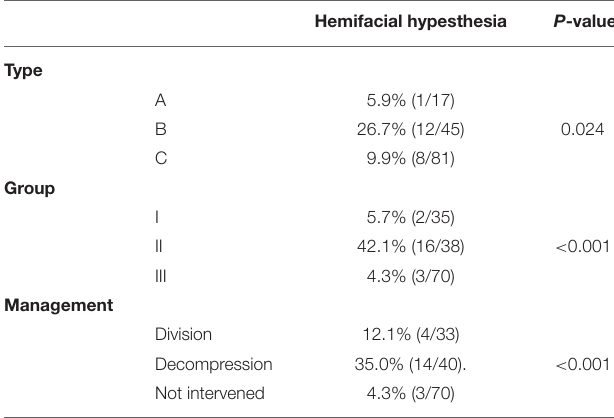
TABLE 2 | The rate of postoperative hemifacial hypesthesia in patients with VO-VREZ of distinct types and groups. Hemifacial hypesthesia P -value